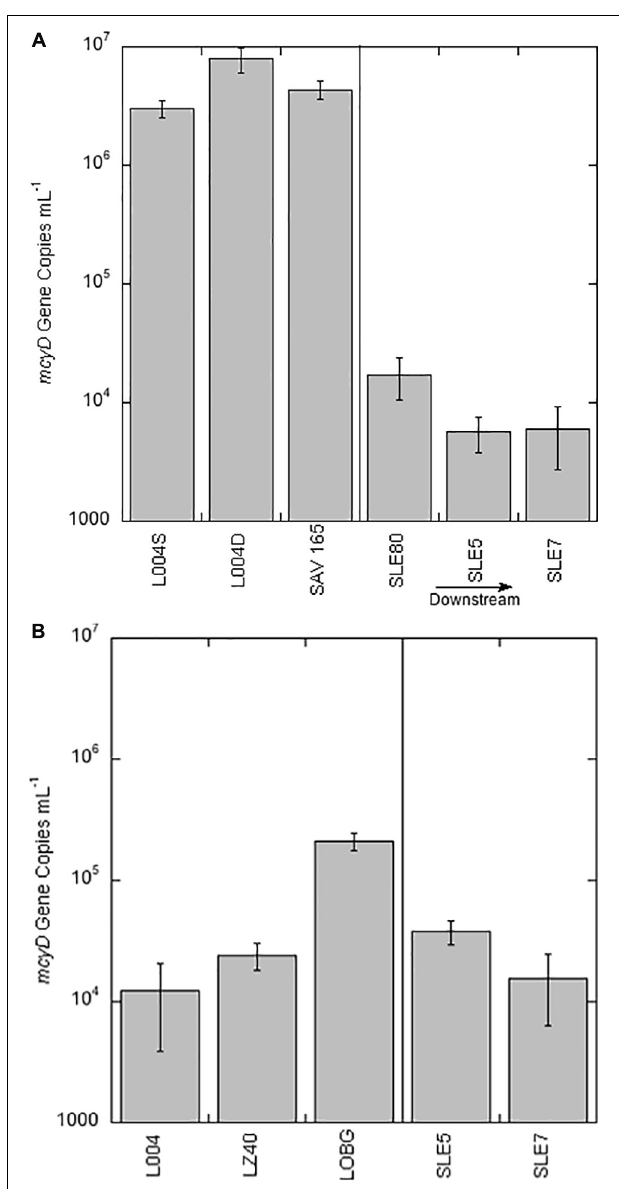
FIGURE 3 | mcyD gene abundance ± one standard deviation in Lake Okeechobee and St. Lucie Estuary in August 2017 (A) and September 2017 (B) . Vertical line divides stations in the lake from stations in the estuary. S = surface water; D = bottom water.